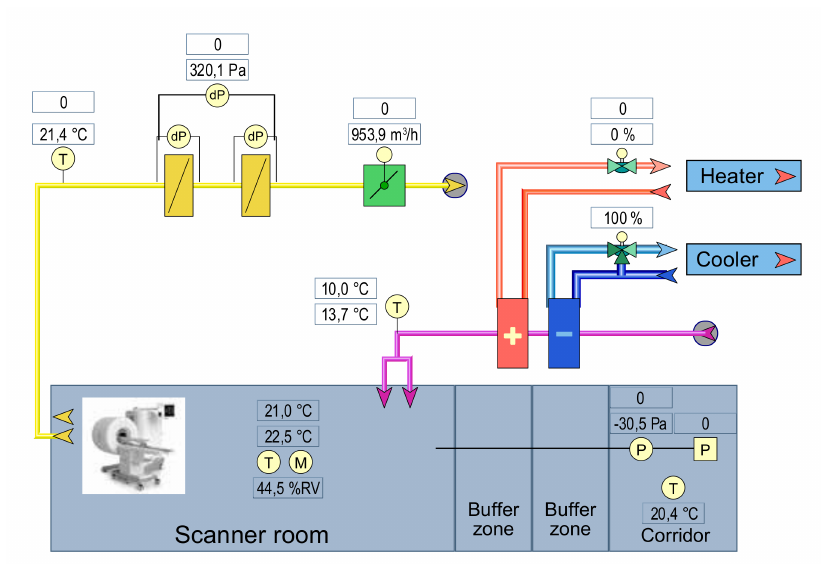
Figure 1. Schematic representation of the scanner room, temperature and air pressure. The tempera- ture set to enter the room is ideally 10.0 ◦ C and the room temperature 21.0 ◦